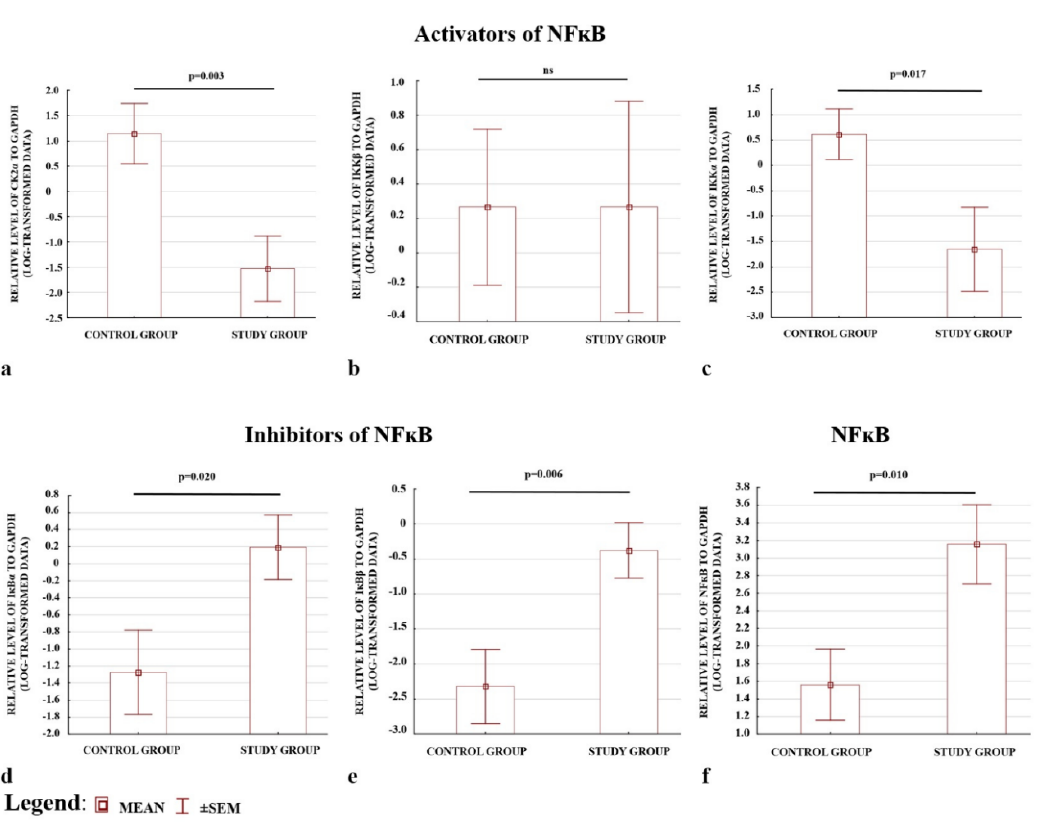
Figure 2. Comparison of the relative levels of activators ( a – c ) and inhibitors ( d , e ) of NF κ B analysed by Western blot. ( f ) Western blotting; NF κ B protein expression normalized to GAPDH. All data are presented as means ± SEM for log-transformed data. Comparison between the study ( N = 29) and control ( N = 29) groups; Mann–Whitney U -test; a p -value of < 0.05 indicates significant results; ns—not significant.